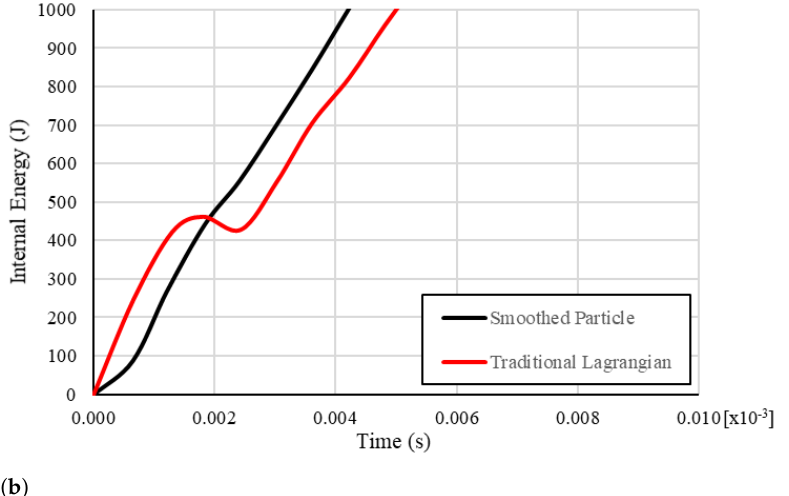
Figure 14. Model Internal Energy versus Time Comparison: ( a ) Full Run Duration, ( b ) Initial Reaction.